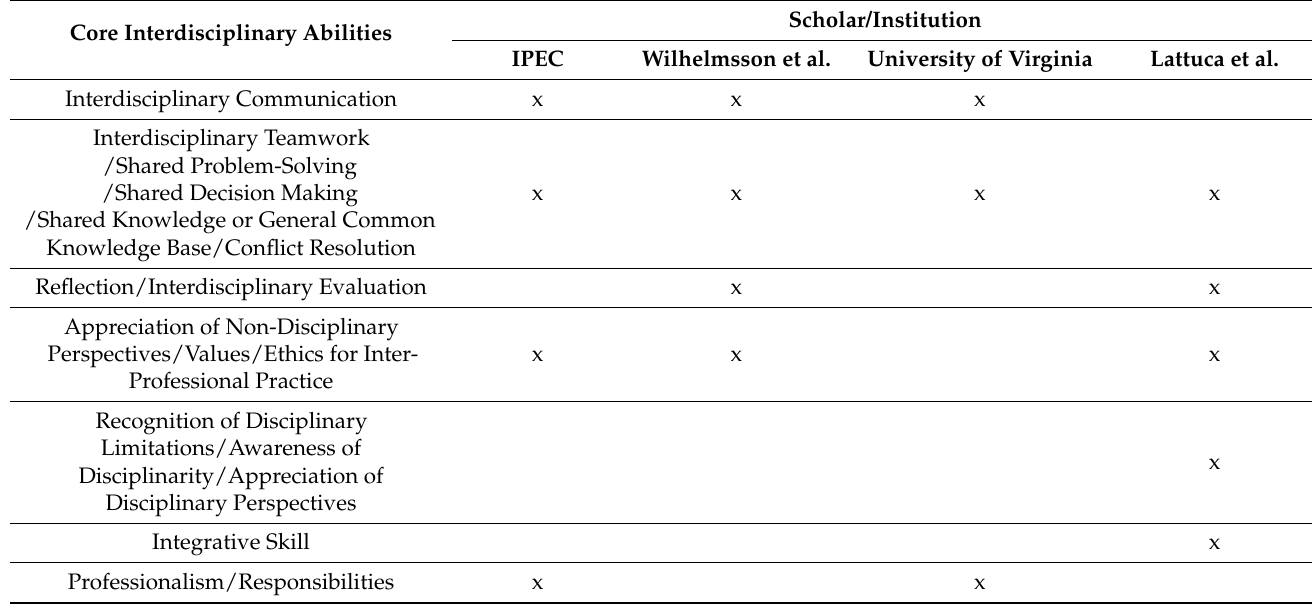
Figure 1. Difference between Multidisciplinarity and Interdisciplinarity. Collated, modified and drawn from Menken Steph, Keestra Machiel, Rutting Lucas, Post Ger, De Roo Mieke, Blad Sylvia, De Greef Linda. 2016. An introduction to interdisciplinary research: Theory and practice. Amsterdam: Amsterdam University Press, pp. 31–32. Table 1. The Above-Mentioned Core Interdisciplinary Integration Abilities .